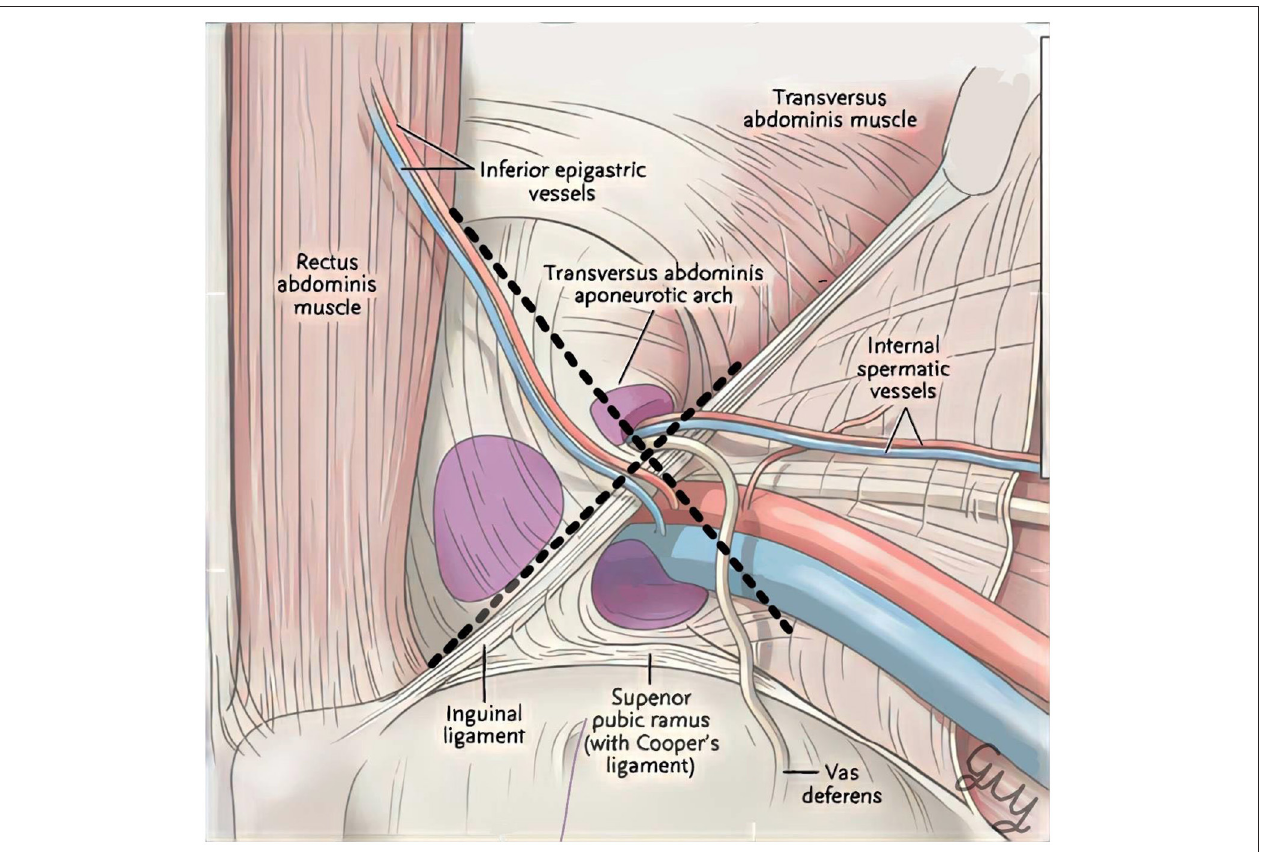
FIGURE 1 | Dimension of the myopectineal